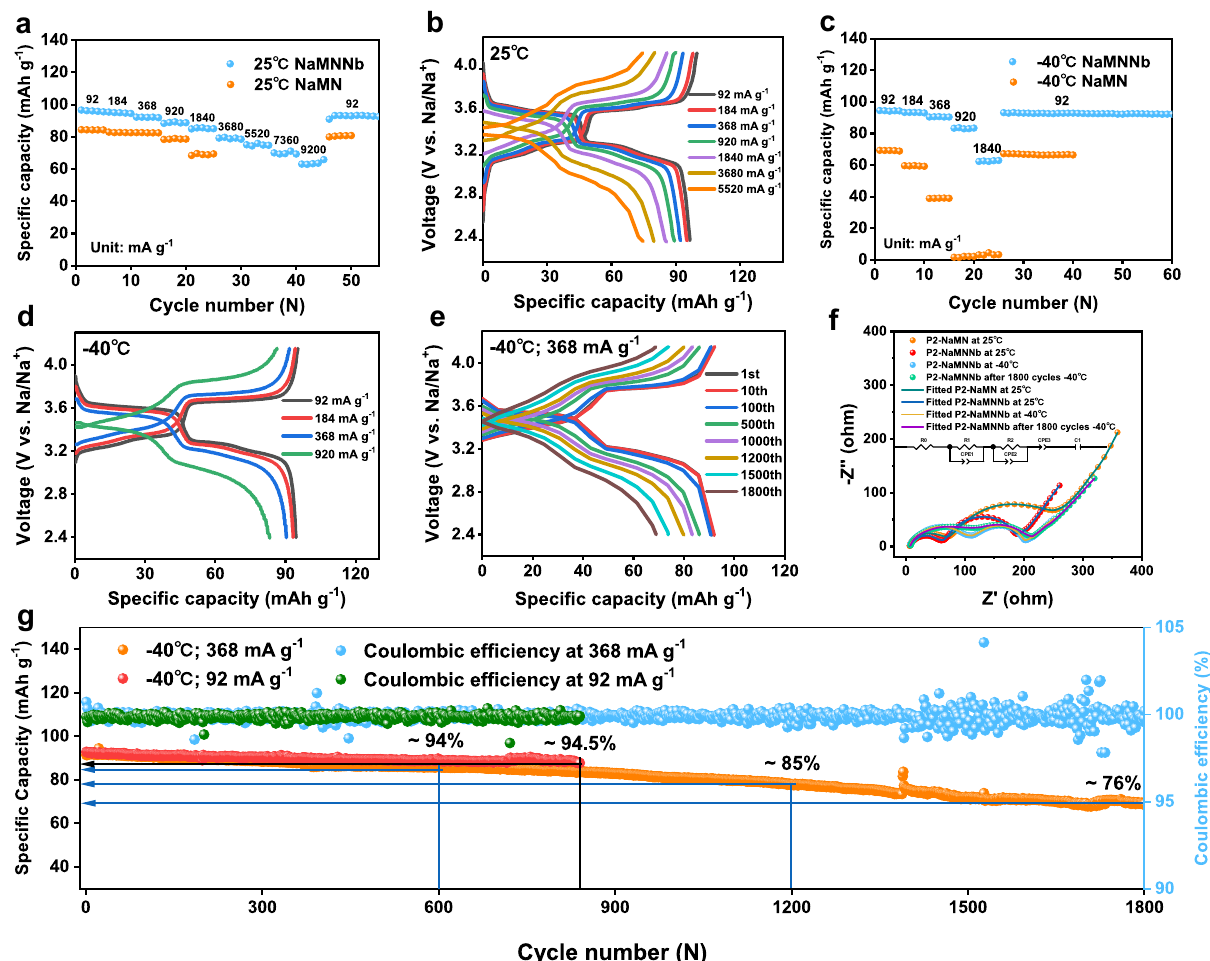
Fig. 4 Electrochemical energy storage performance of Na||P2-NaMNNb and Na||P2-NaMN coin cells at various temperatures. a The rate performance comparison of Na||P2-NaMNNb and Na||P2-NaMN at 25 °C. b Charge and discharge curves of Na||P2-NaMNNb at various rates at 25 °C. c The rate performance comparison of Na||P2-NaMNNb and Na||P2-NaMN at − 40 °C. d Charge and discharge curves of Na||P2-NaMNNb at various rates at − 40 °C. e Charge and discharge curves of Na||P2-NaMNNb coin cells at various cycle numbers at − 40 °C and 368 mA g − 1 . f EIS curves of P2-NaMNNb and P2-NaMN at 25 °C and − 40 °C. g Long-term cycling stability at rates of 92 and 368 mA g − 1 at − 40